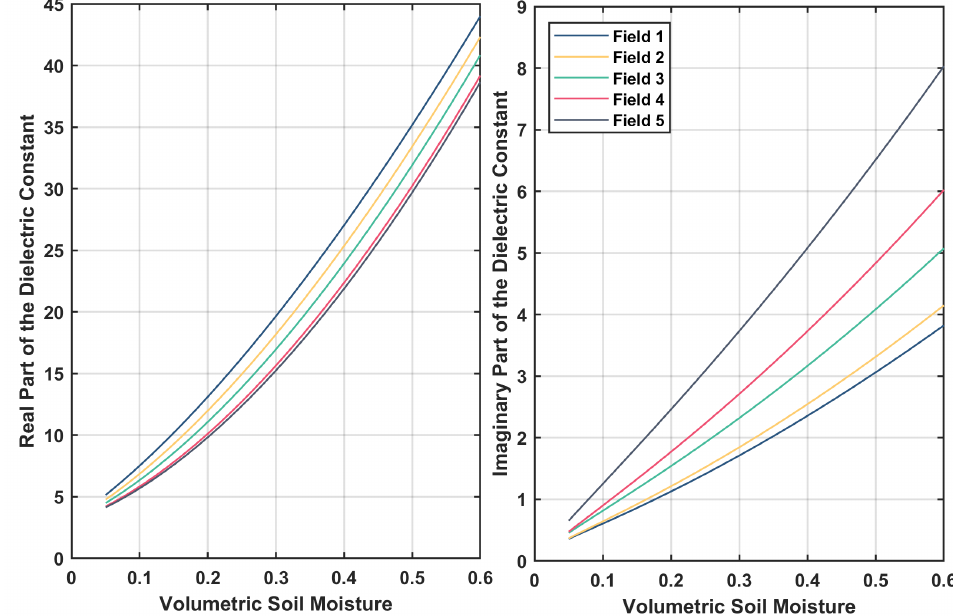
Figure 2. The relationship between the real part and the imaginary part of the dielectric constant with the soil moisture content under different soil